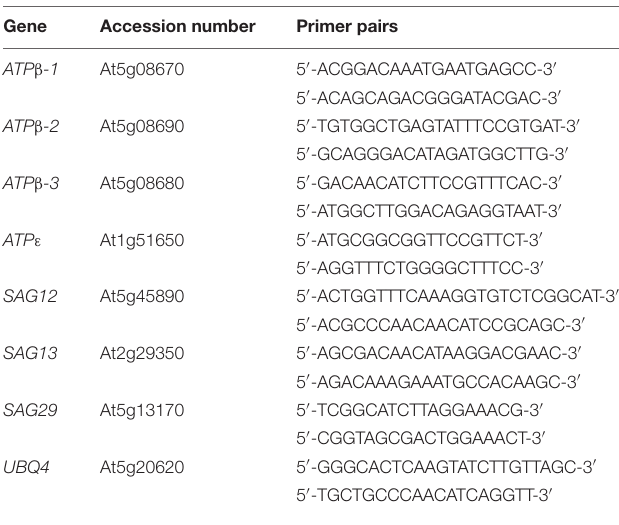
TABLE 1 | List of primers for